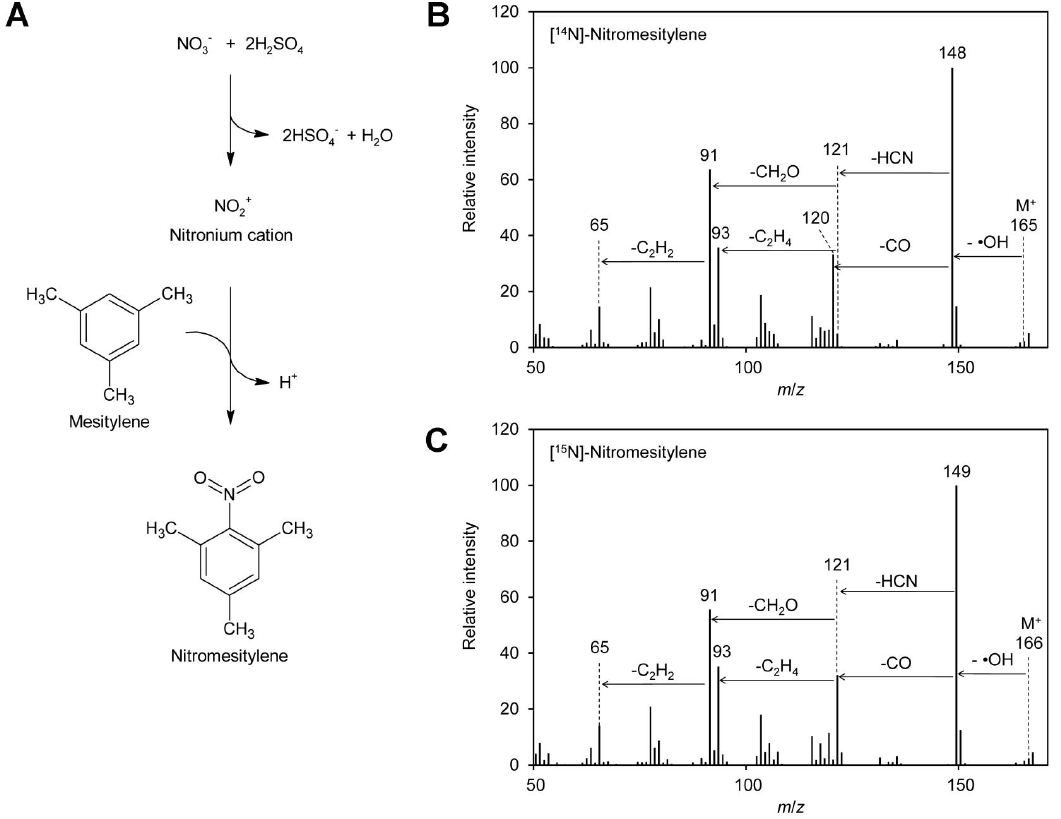
Figure 1. Formation of nitromesitylene and MS spectra. ( A ) Nitrate reacts with sulfuric acid to the nitronium cation, which reacts subsequently with mesitylene to form nitromesitylene. ( B ) EI–MS spectrum of [ 14 N]-nitromesitylene. Neutral losses of a hydroxyl radical ( · OH), carbon monoxide (CO), and hydrogen cyanide (HCN) are indicated. ( C ) EI–MS spectrum of [ 15 N]-nitromesitylene. Original data are presented in Supplementary File